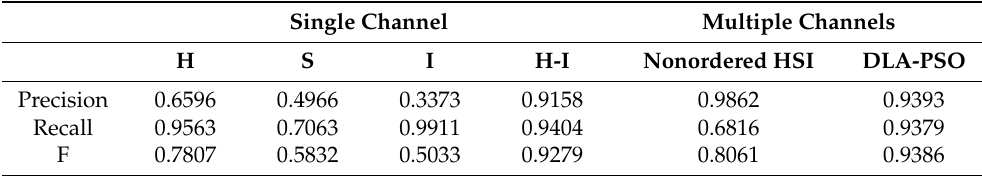
Figure 4. ( a ) Original image; ( b ) hue channel; ( c ) saturation channel; ( d ) intensity channel; ( e ) H-I channel; ( f ) nonordered HSI; ( g ) DLA-PSO. Table 1. Comparative evaluation for designed channels. Table 1. Comparative evaluation for designed